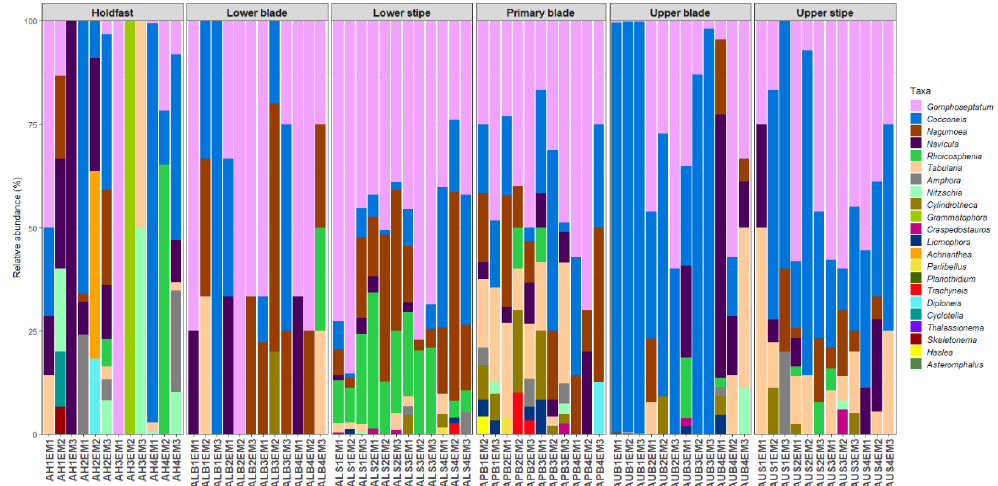
ff erent parts of adult specimens of Ecklonia maxima